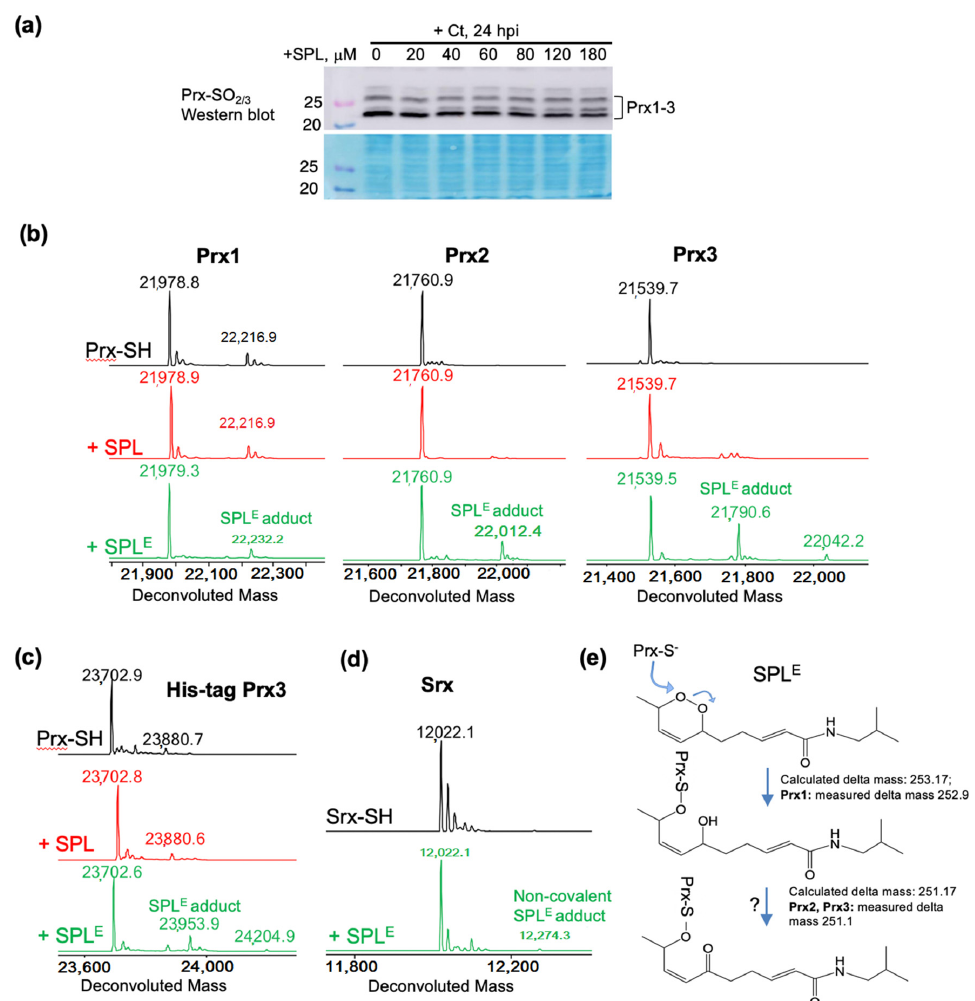
Figure 4. Reaction of SPL E but not SPL with reduced peroxiredoxins. ( a ) Western blot analysis of hyperoxidized Prx(1–4) in HeLa cells showing that SPL does not increase the level of hyperoxidized Prx in Ct infected cells. Protein stain is shown to illustrate equal loading of cell lysates; ( b ) ESI-TOF MS data of Prx1, Prx2 and Prx3 after reduction with DTT (black upper spectra), and after the reaction with SPL (red middle spectra) or SPL E (green lower spectra). The results show lack of reaction with SPL and preferred reaction of SPL E with Prx3, as well as formation of a more oxidized adduct with Prx2 and Prx3 (delta mass +251.1) compared with Prx1 (delta mass +252.9); ( c , d ) The same reaction as in ( b ) but using a His-tagged construct of Prx3 ( c ), showing the dependence of the reaction on the oligomeric structure of native Prx3, and using Srx ( d ) showing lack of reaction with this protein; ( e )